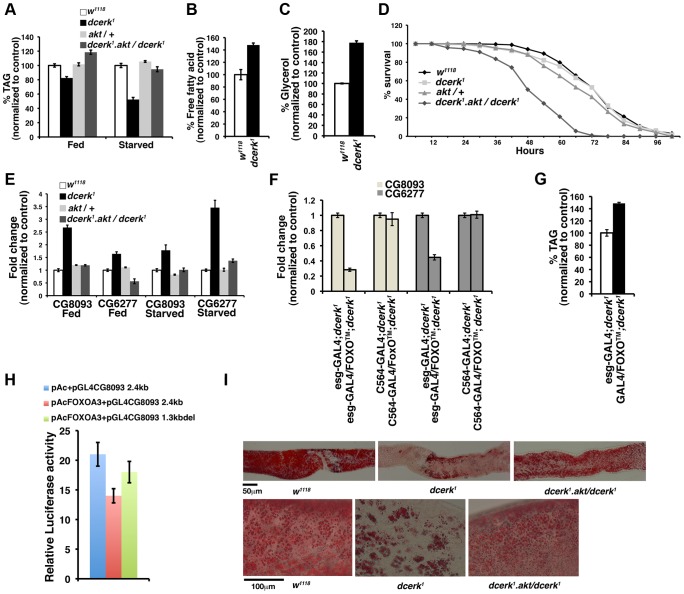
CG8093 and CG6277 are novel lipases in the gut activated by AKT/FOXO in dcerk1.(A). Relative TAG level in ad libitum fed dcerk1 is 80% of w1118 and increases to 120% when AKT is reduced. Relative TAG level in 20 hr starved dcerk1 is 50% of w1118 and significantly increases when AKT is reduced. n = 3, error bars represent standard deviation. (B). Free fatty acids were measured in lysates prepared from starved w1118 and dcerk1 flies. Mutants show increased free fatty acids compared to w1118. (C). Glycerol was measured in lysates prepared from starved w1118 and dcerk1 flies. Mutant shows increased glycerol compared to w1118. (D). w1118, dcerk1, akt/+ and dcerk1.akt/dcerk1 flies are subjected to starvation and the number of surviving flies is recorded at 6 hr intervals. 200 flies divided into 10 groups for each genotype are used in one experiment. Three independent experiments are performed and the average percentage survival relative to w1118 is shown for each time interval. Reduction in AKT increases the starvation sensitivity of dcerk1 flies. (E). QPCR analysis shows transcript levels of two lipases CG8093 and CG6277 (identified by microarray analysis) are increased in dcerk1 relative to w1118 both in the fed and 20 h starved state. Both transcript levels are decreased upon reduction of AKT in dcerk1. n = 3, error bars represent standard deviation. (F). Overexpression of constitutively active FOXO in the midgut decreases whole animal transcript levels of CG8093 and CG6277 while fat body specific expression does not significantly affect them in dcerk1. FOXO overexpression with each driver is quantified by QPCR using FOXO primers and normalized. n = 3, error bars represent standard deviation. (G). Midgut specific overexpression of constitutively active FOXO increases whole animal TAG level in dcerk1. The TAG level in dcerk1 expressing esg-GAL4 driver is taken as 100%. (H). Constitutive FOXO represses CG8093 in luciferase reporter assays. A 2.4 kb fragment (genomic region between 1773 bp to 4177 bp from transcription start site) containing FOXO core motifs upstream of CG8093 in a luciferase reporter vector or a 1.3 kb fragment (region between 2842 bp and 4177 bp) deficient of the FOXO motifs was cotransfected with constitutive dFOXO A3. FOXO represses transcription of the 2.4 kb fragment while the repression is less when the binding sites are deleted. (I). Dissected adult midguts stained with Oil Red O show significantly reduced lipid staining in starved dcerk1 compared to w1118. dcerk1 mutants with reduced AKT show comparatively more Oil Red O staining in the midgut. 15–20 guts are examined for each genotype in one experiment, which is carried out three times. Scale bar represents 50 µm. Magnified view of dissected adult midguts from w1118 and dcerk1.akt/dcerk1 show many Oil Red O stained puncta while they are significantly reduced in dcerk1. Scale bar represents 50 µm.